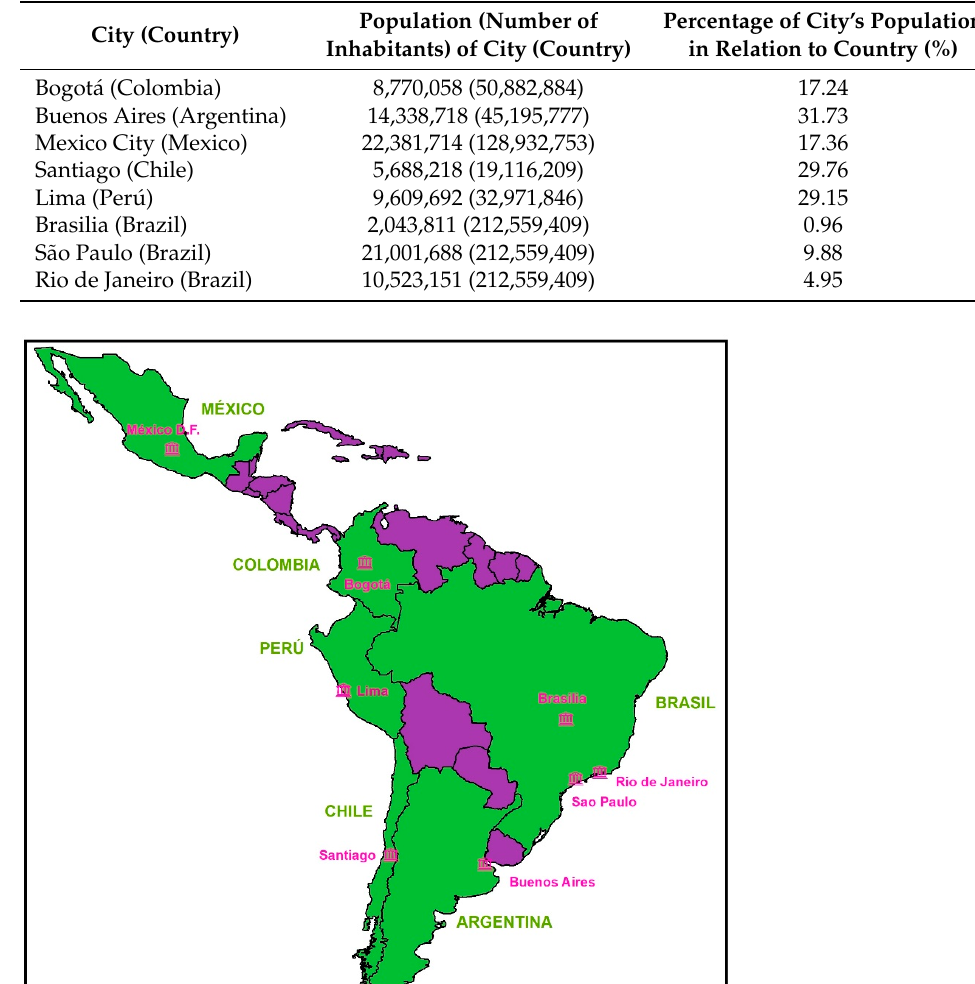
Table 1. Population of the cities and countries under study.